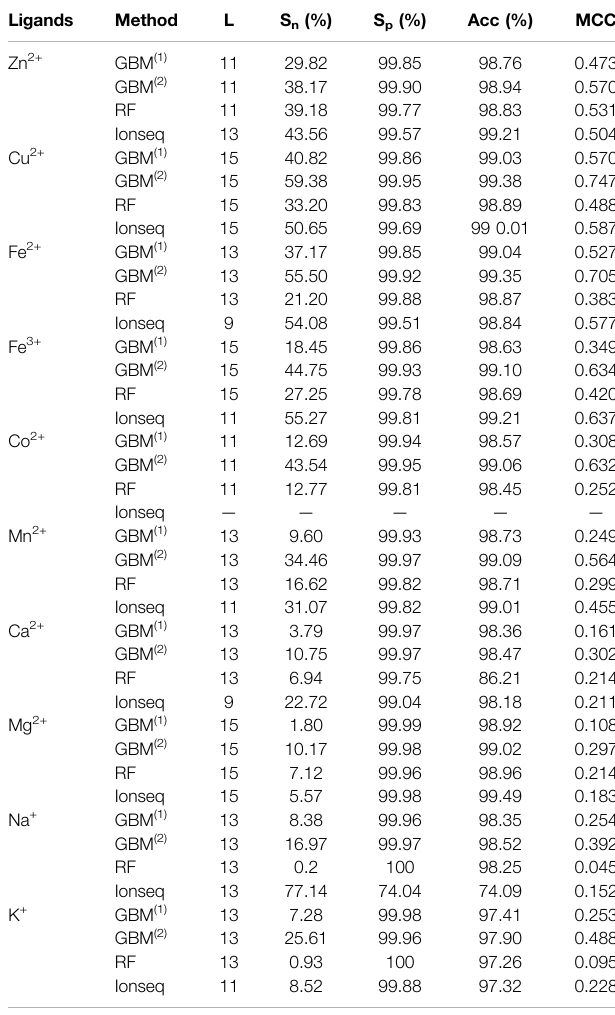
TABLE 5 | Comparison of 5-fold cross-validation